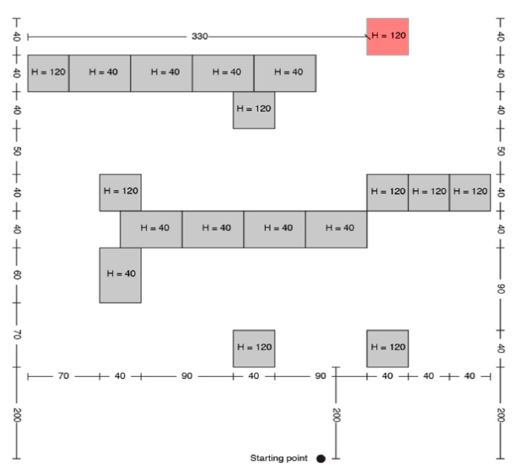
Figure 8. Treasure hunt configuration D.